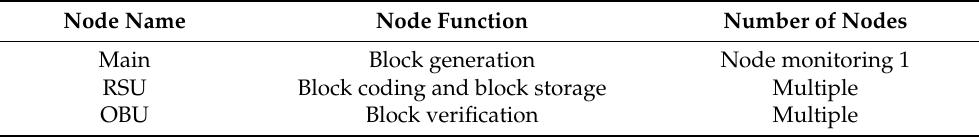
Table 3. Network node types.